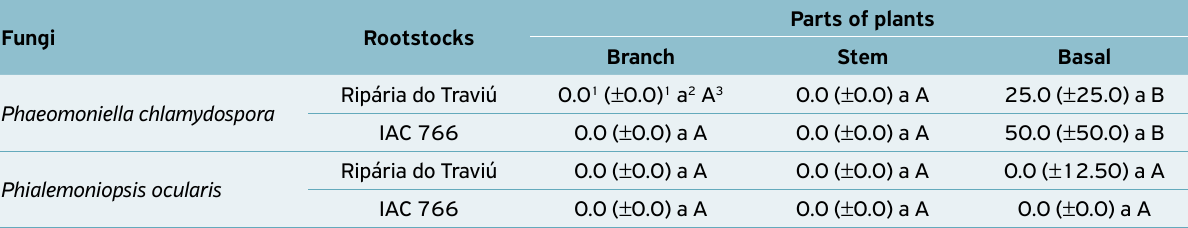
Table 3. Median values and quartile semi-amplitude of the percentage of incidence of Phaeomoniella chlamydospora and Phialemoniopsis ocularis fungi in samples removed from the vascular system of different parts of ‘Niagara Rosada’ vines grafted on two different rootstocks.